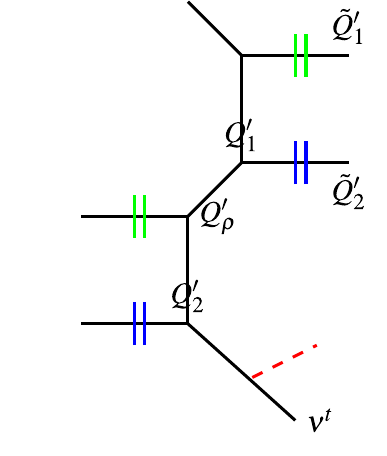
Fig. 6 Equivalent to toric diagram in Fig.